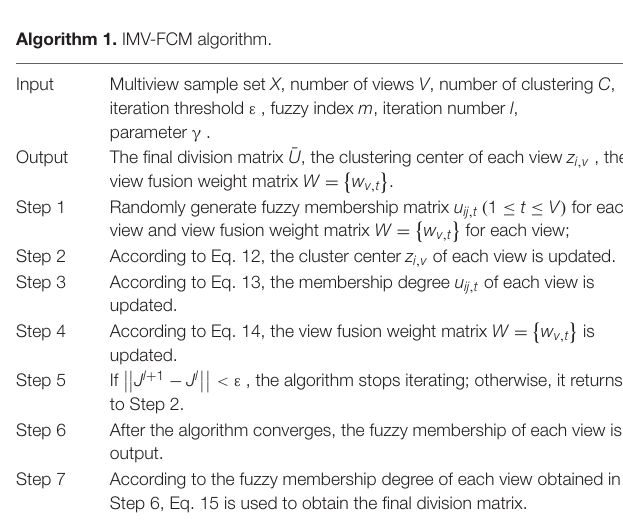
Algorithm 1. IMV-FCM